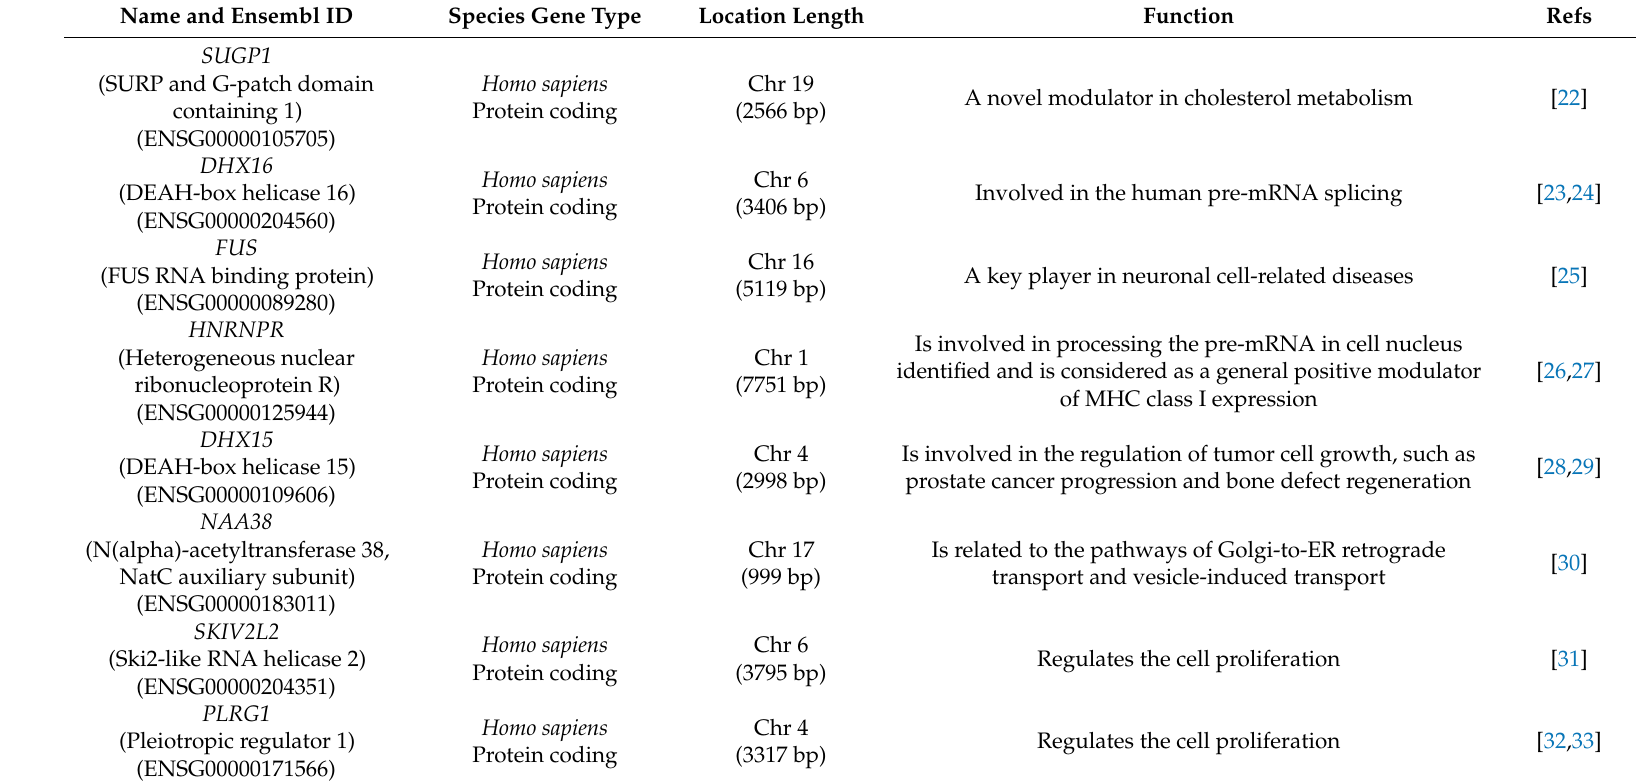
Table 6. Electric field-sensitive hub